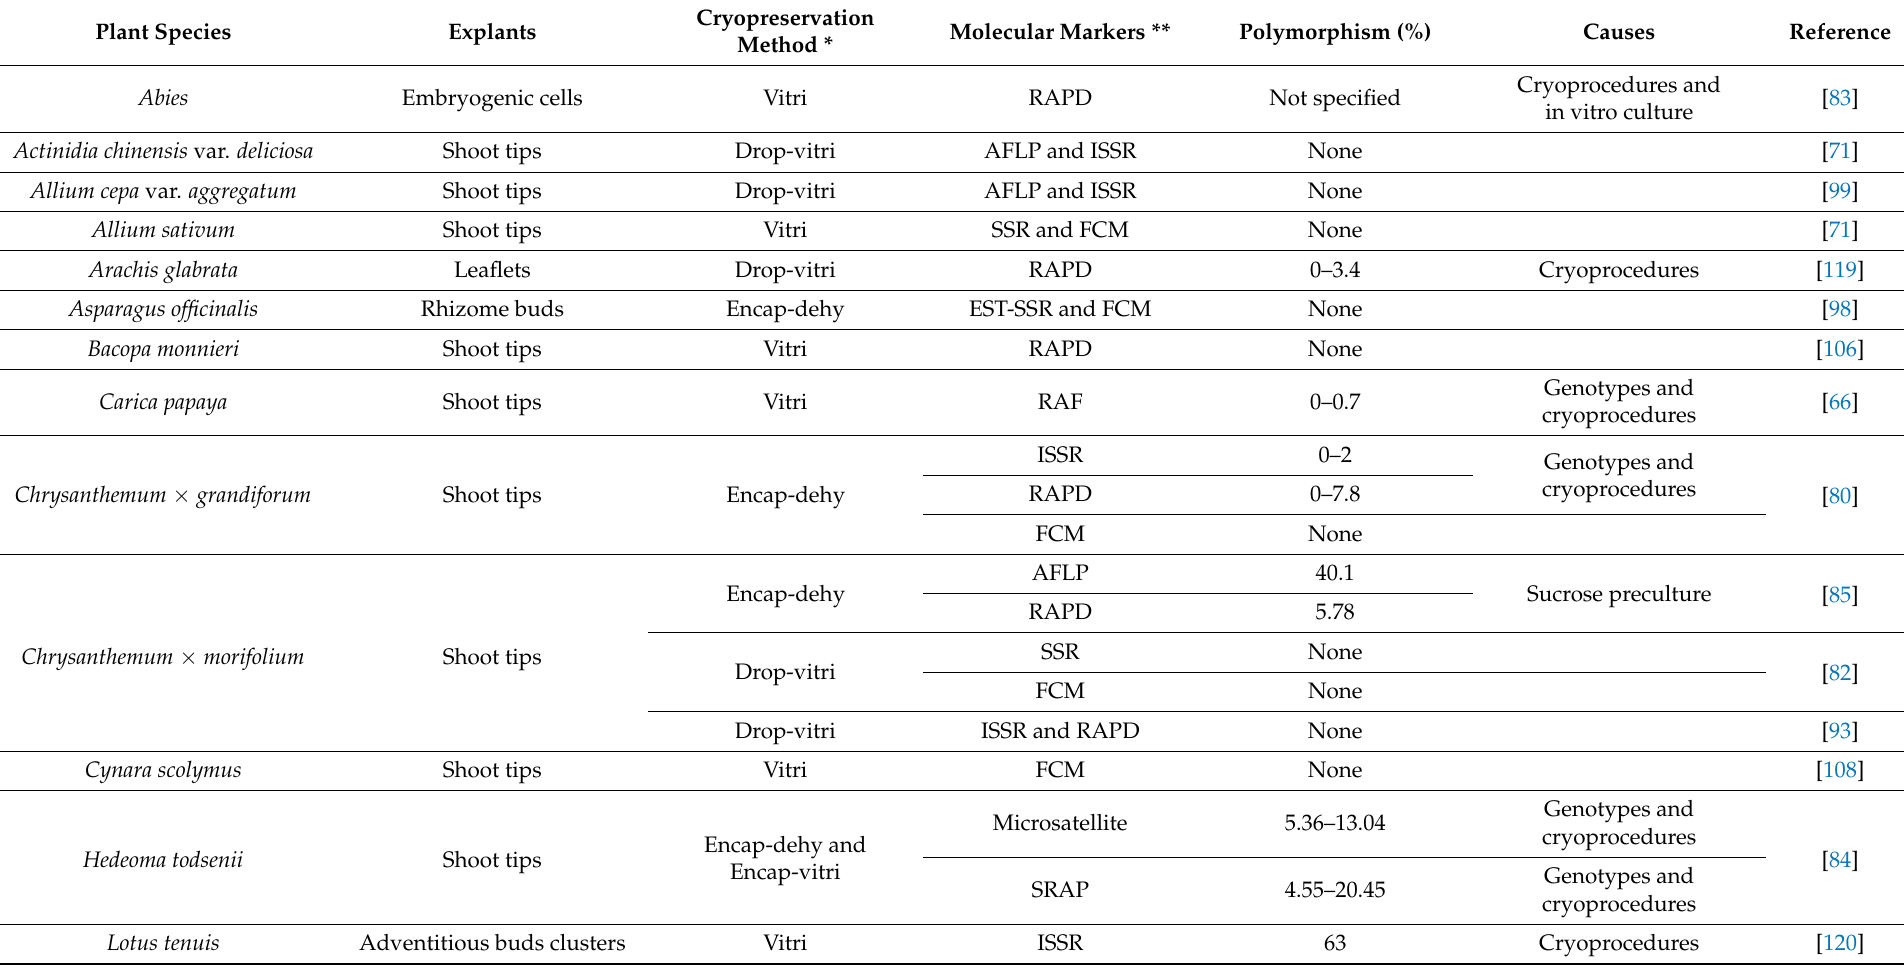
Table 2. Some examples from the past decade of genetic integrity assessments by molecular markers and FCM in regenerants recovered after